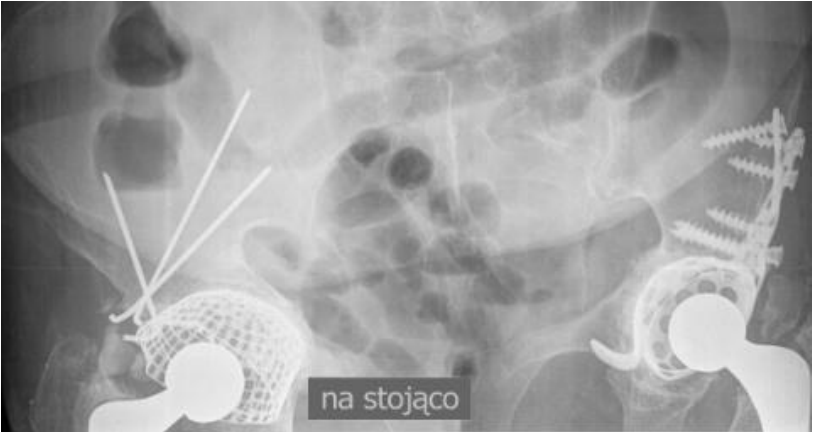
Figure 4. An X-ray of the abdomen visualizing both hip joints 13 years following successful right hip revision